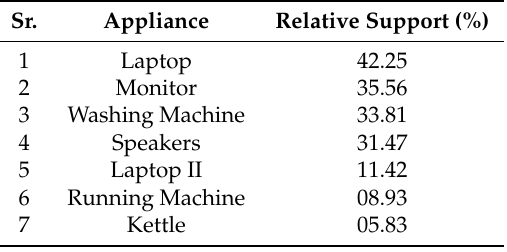
Table 10. House 3: appliance usage priority in 50% training dataset.